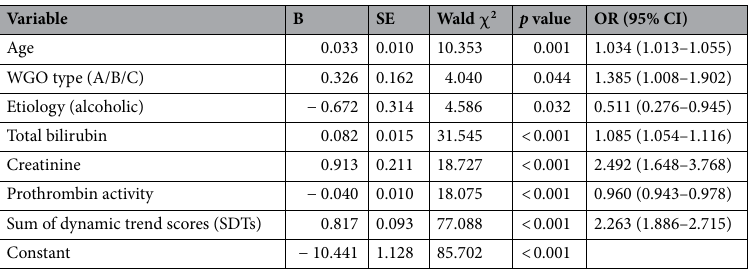
Table 3. Logistic regression analysis of 90-day survival rates. SDTs Sum of dynamic trend